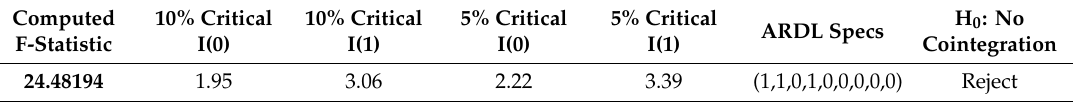
Table 20. The results of the bounds test for cointegration